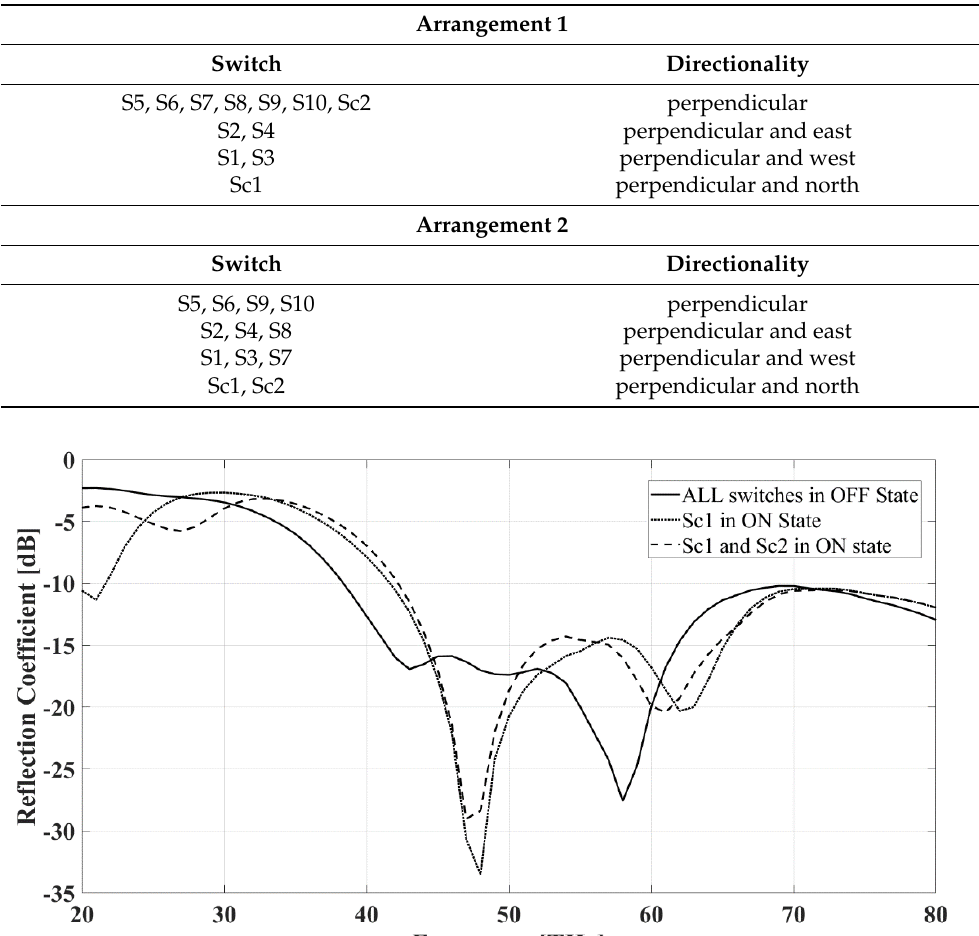
Table 1. Directionalities of the bolometers in the pixel antenna structure.